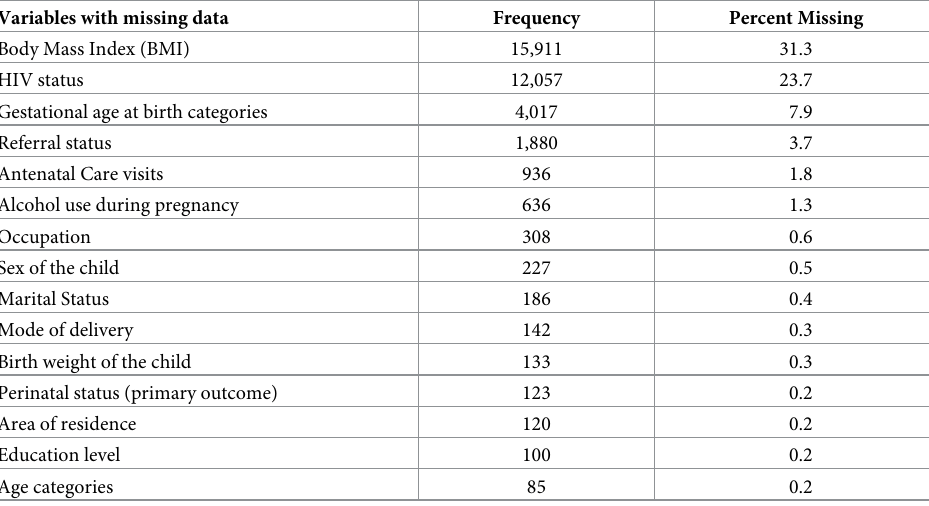
Table 3. Distribution of missing values in the KCMC medical birth registry, 2000–2015 (N = 50,847). Variables with missing